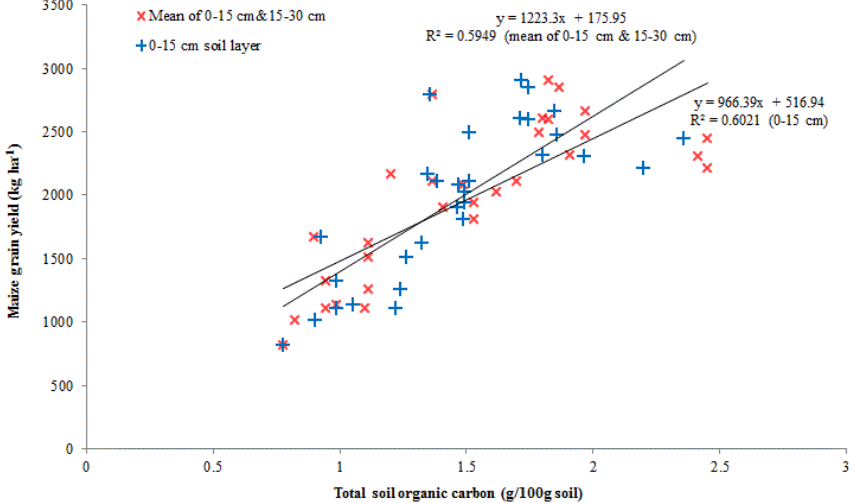
Figure 2. Relationship between maize grain yield and soil organic carbon in a Ferralsol of